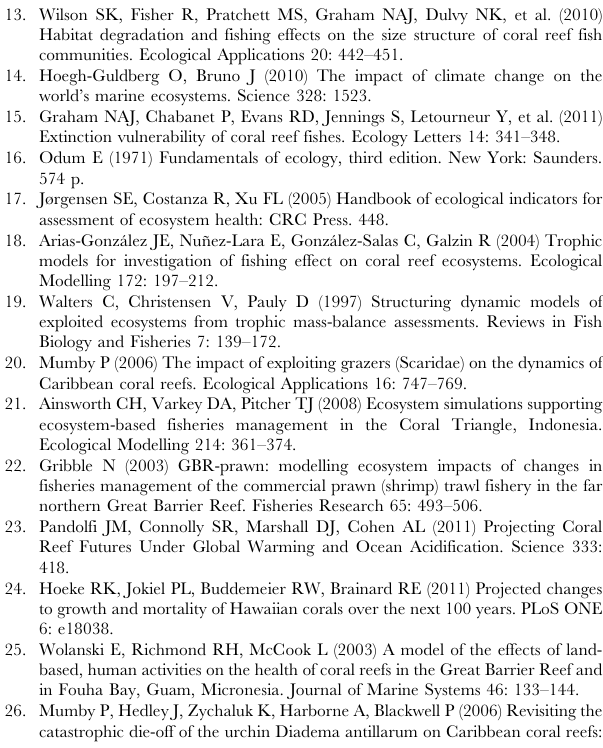
Table S8 Diet composition matrix of the functional groups included in a reef system around O’ahu. Import indicates feeding outside of the modeled area. Numbers in column headings (predators) correspond with row numbers (prey). The sum of the diet composition (column) equals to 1. CCA is crustose coralline algae. CCA is crustose coralline algae. Column headings correspond to the row headings. (TIF) Text S1 Supplementary material specific to the 33 functional groups. Explanation and sources of used Ecopath values in the three Hawaiian studies and diet composition of each